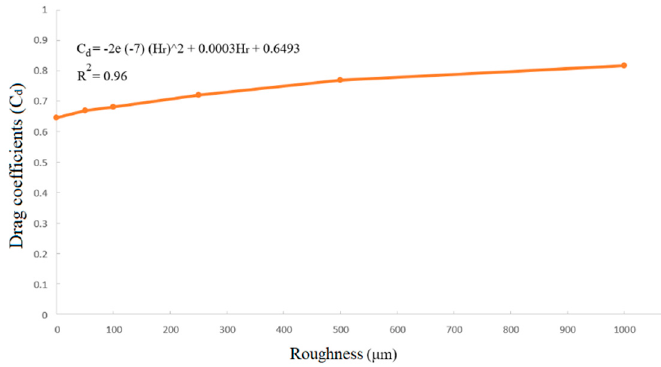
Figure 12. Variations of drag coe ffi cient ( C d ) at di ff erent roughness